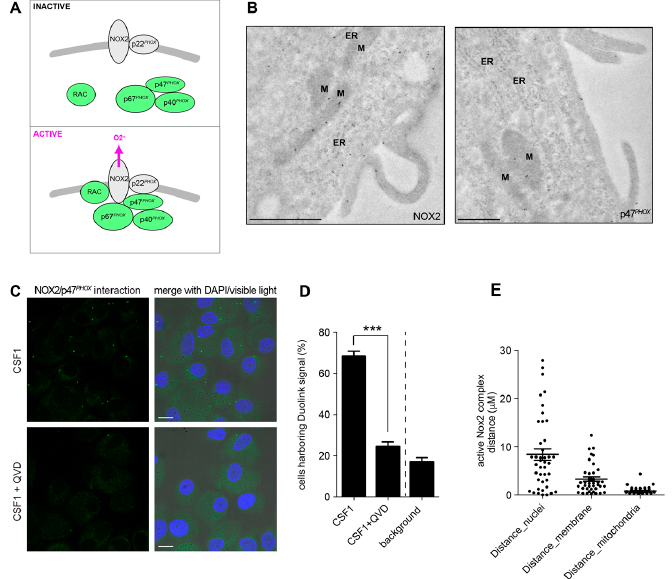
Figure 5. Detection of caspase dependent-active NOX2 complex in mitochondria of CSF1-treated monocytes. ( A ) Assembly of the NOX2 complex: inactive state (upper panel), active state (lower panel). ( B ) Immunogold labeling of NOX2 and p47 PHOX analyzed by electron microscopy in CSF1-treated monocytes. Scale bar, 1 µm. ER, endoplasmic reticulum; M, mitochondrion. ( C ) In situ proximity ligation assay (PLA) of p47 PHOX and NOX2 in CSF-1 treated monocytes (100 ng/mL, 4 days) in the absence or presence of Q-VD-OPh (50 µM). Left panel, specific signal in green; right panel, overlay with nuclear staining with DAPI in blue; Scale bar, 10 µm. ( D ) Fraction of cells harbouring a signal in PLA (***, p < 0.001; Fisher Exact Test). Mean ± SE. ( E ) Measurement of the distance from PLA signal to the nucleus, the membrane or the mitochondria. Circles were drawn, centered on forty-two PLA signals. The Distance_nuclei, Distance_membrane, and Distance_mitochondria correspond to the shorter radius to encounter the nucleus, the plasma membrane or the mitochondria.